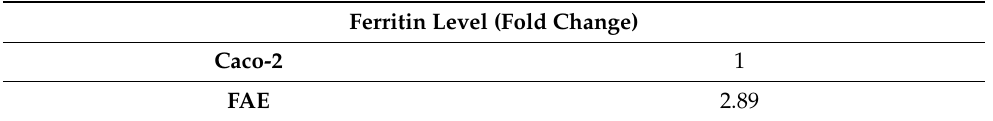
Table 7. Ferritin in Caco-2 cells and in human intestinal follicle-associated epithelium (FAE) mono- layers exposed for 3 h to bioaccessible fractions of Ferro Fosfosoma ® . Ferretin levels are expressed as fold changes using Caco-2 monolayer as a reference.